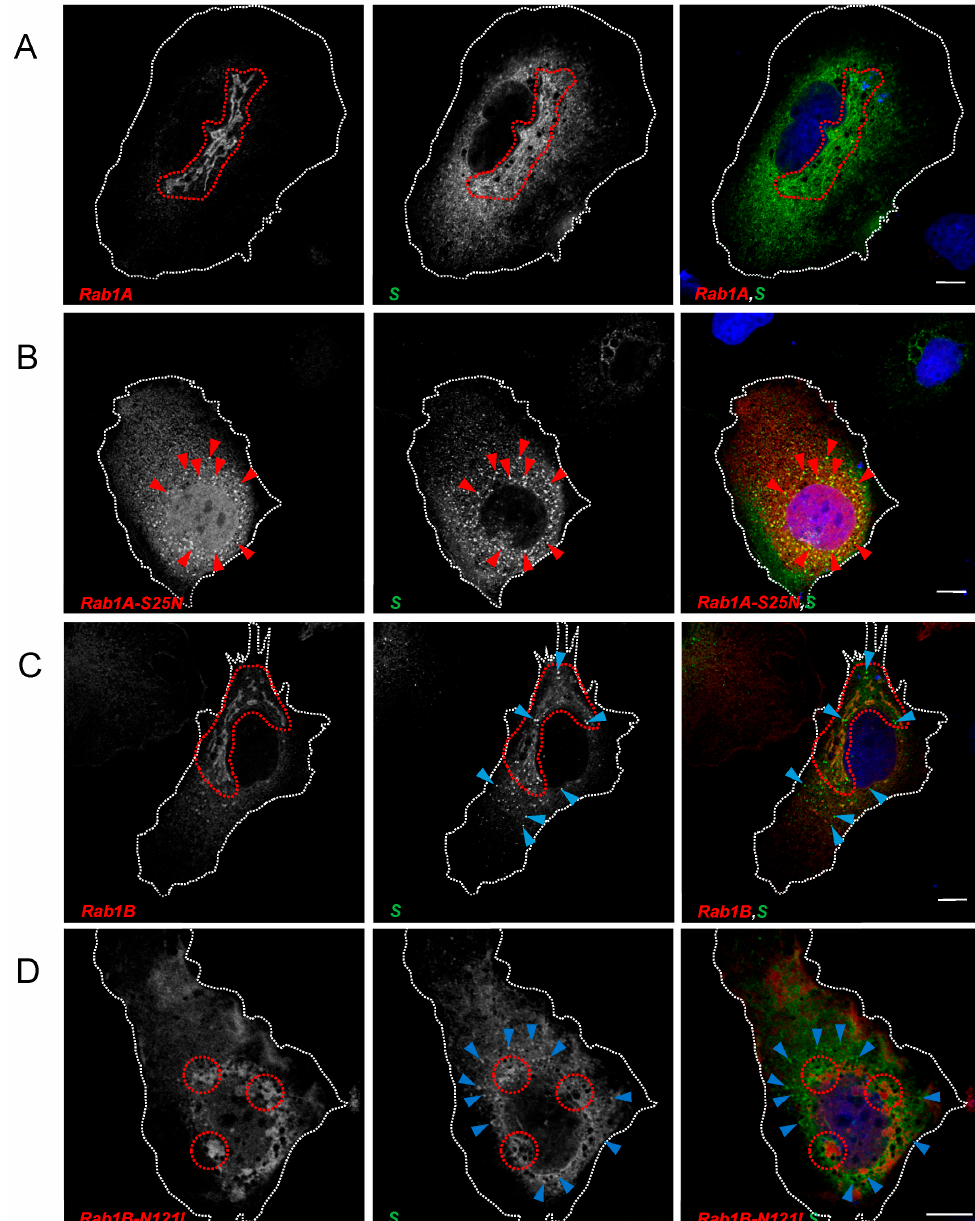
Figure 3. Rab1A and Rab1B are involved in SARS-CoV-2 S transport. Subconfluent HuH7 cells were transfected with 500 ng pCAGGS-S and 1000 ng ( A ) pCMV-Rab1A-myc, ( B ) pCMV-Rab1A-S25N-myc, ( C ) pCMV-Rab1B-myc or ( D ) pCMV-Rab1B-N121I-myc, respectively. Cells were fixed 24 hpt and stained for SARS-CoV-2 S (green), Rab1A/Rab1B (anti-myc, red) and nuclei (blue) with DAPI. Scale bars indicate 10 µm. Encircled areas in ( A – C ) highlight regions of colocalization between S and Rab1 variants. Red arrows in ( B ) point to distinct vesicular structures where S and Rab1A-S25N colocalize. Blue arrows in ( C ) point at vesicle-like structures of S that do not colocalize with Rab1B. In ( D ), encircled areas highlight the close proximity of S and DN Rab1B-N121I. Blue arrows point to accumulations of punctate structures that do not colocalize with Rab1B-N121I. Data are representative of three independent experiments.